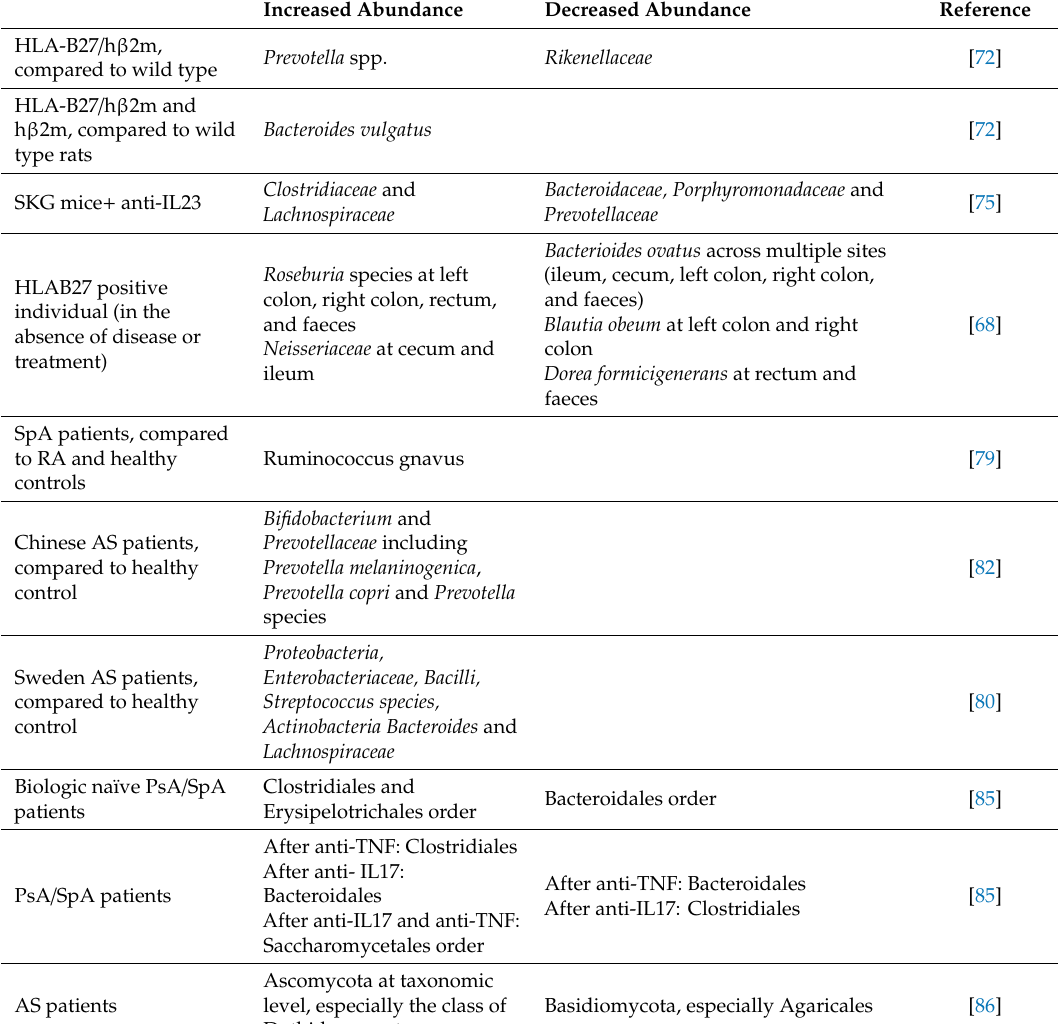
Table 2. Altered Gut Microbiota in Faecal Samples in SpA Compared to Healthy Individuals in Animal and Human